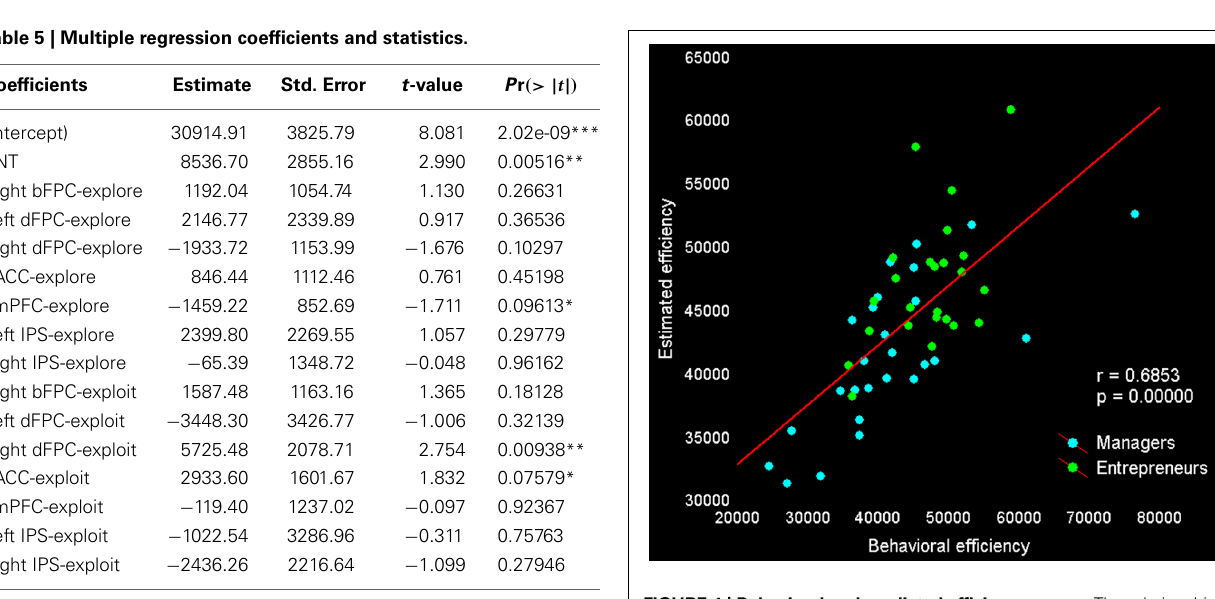
FIGURE 4 | Behavioral and predicted efficiency scores. The relationship between behavioral decision-making efficiency (payoff divided by response time) during f MRI scanning and estimated efficiency, based on the activity of seven regions reported in previous studies and showing a significant difference between exploitative and explorative choice [vmPFC, bilateral FPC, and IPS from Daw et al. (2006); right FPC by Boorman et al. (2009); dorsal sector of anterior cingulate cortex by Kolling et al.